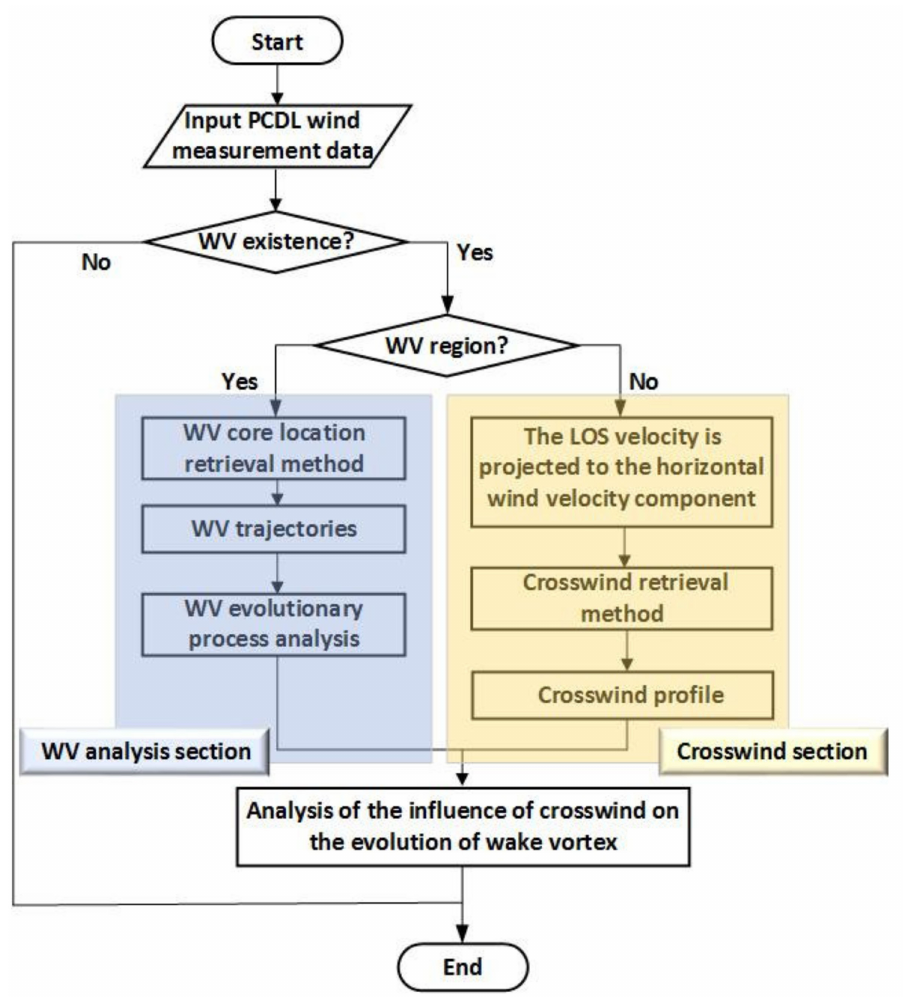
Figure 3. Flow chart of the RHI data processing. The wake vortex makes the radial velocity distribution of PCDL RHI scans different to the ambient wind field with the crossover structure of positive and negative values; thus, it is possible to separate the wake vortex from the environment wind field, as shown in Figure 4a. Apart from the anomaly of radial velocities, wake vortex tangential velocities also cause the spectrum to broaden. In a single sampling volume, the FFT spectrum data in the wake vortex region usually have three Doppler velocities—-the main spectral velocity, the minimum velocity, and the maximum velocity [14,32]—-when a certain threshold is given. The minimum or maximum velocity related to vortex tangential velocity can be used as an indicator for the presence or absence of the wake vortex in PCDL RHI scans. The Doppler shift difference between the minimum and maximum velocities is called the spectrum width in this paper. Figure 4b shows the spectrum width distribution in RHI scans when an A333 aircraft landed at CSIA at 13:29 on 26 August 2018. The wake vortex induced significant spectral broadening at 500 m away from PCDL, as shown in Figure